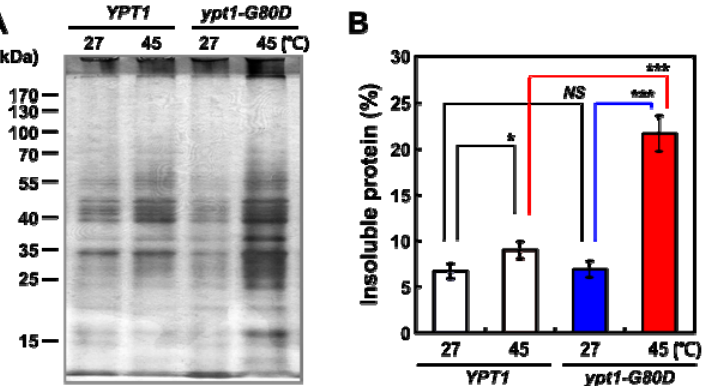
Figure 2. Heat-Shock-Induced Cytosolic Protein Aggregation in Yeast Cells. ( A ) Heat-shock-induced cytosolic protein aggregation in YPT1 and ypt1-G80D cells. The cells (5 × 10 7 cells/mL) were grown in YPD medium and incubated at 27 °C or 45 °C. Samples were withdrawn at the 60 min time point,